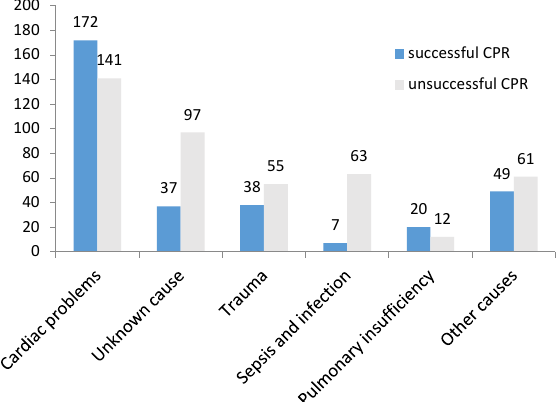
Figure 3. The number of successful and unsuccessful CPR considering different causes of cardiac arrest.